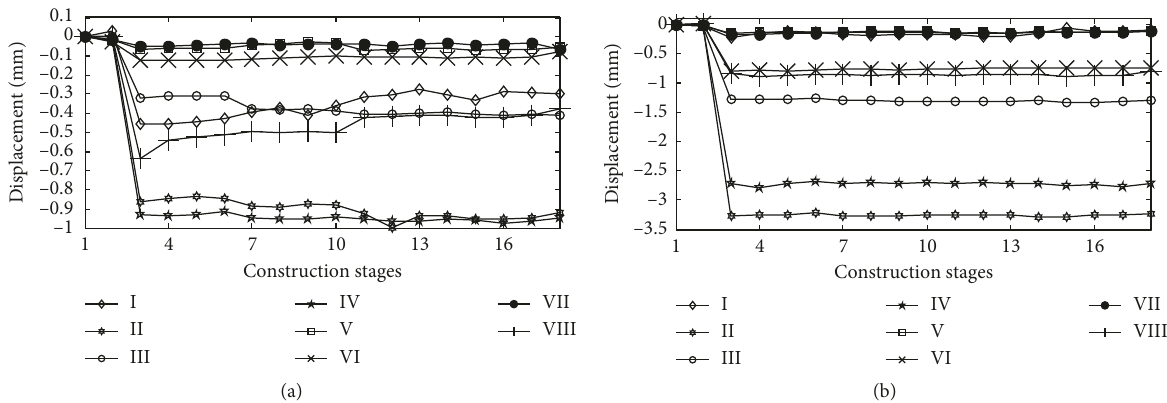
Figure 15: Relative vertical displacement of adjacent buildings: (a) relative vertical displacement of the left building; (b) relative vertical displacement of the right building.